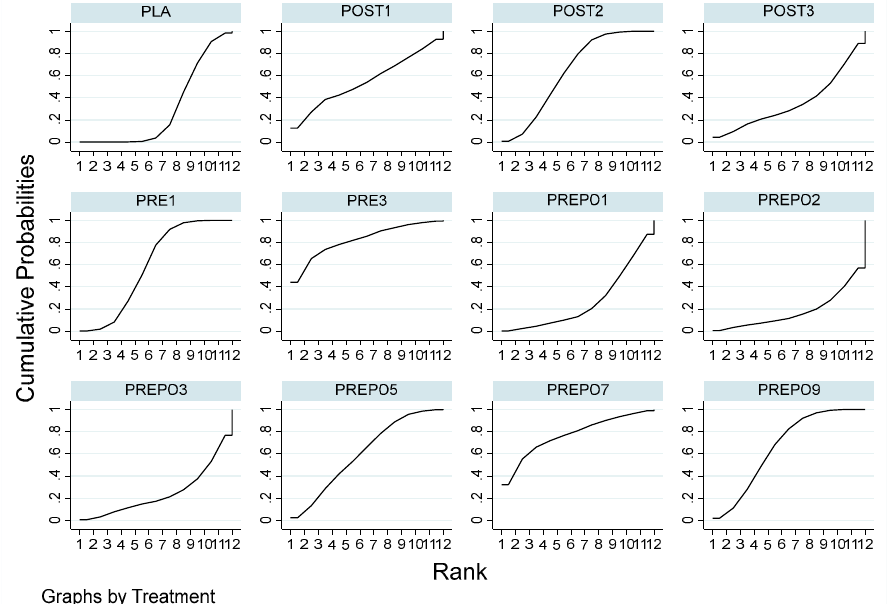
Figure 3. SUCRA ranking curve in implant failure (per patient). Abbreviations: PRE1 = 2 g amox 1